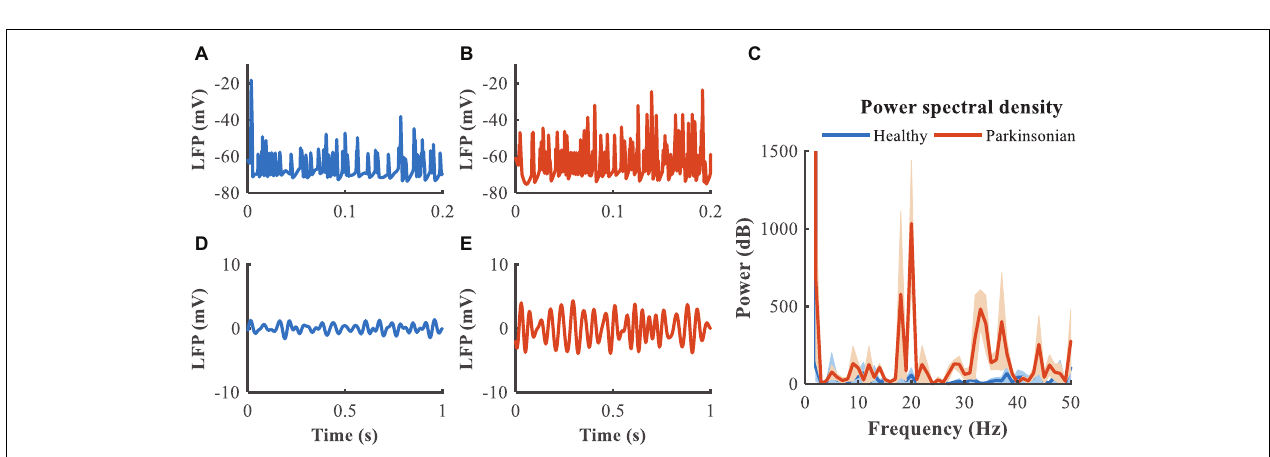
FIGURE 4 | Characterization of model neuron activity in healthy and Parkinsonian conditions. (A) Firing rates (mean ± standard error) for model STN, GPe, and GPi neurons in healthy (blue) and Parkinsonian (orange) conditions. Values are averaged across three runs for each nucleus. (B) Spike synchrony (mean ± standard error) for model STN, GPe, and GPi neurons under healthy (blue) and Parkinsonian (orange) conditions. All model neurons exhibit increases in spike synchrony in the Parkinsonian state as compared to the healthy state. (*** represented a significant difference, p < 0.001).